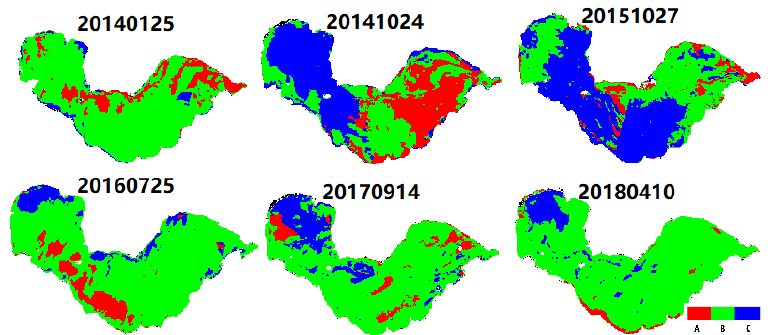
Figure 9. Whole water-body classification in Chaohu Lake from 2014 to